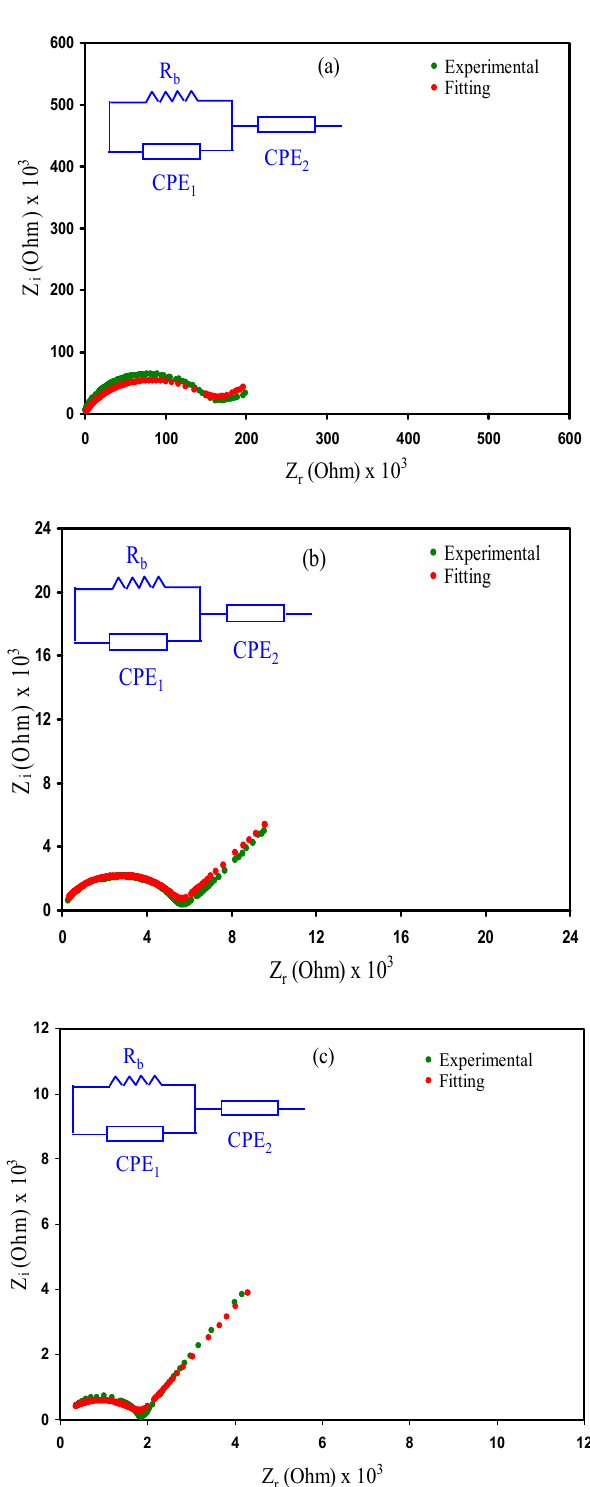
Figure5. Compleximpedanceplot( Z i versus Z r )forthe( a )CSPVMG1, ( b )CSPVMG2, and( c )CSPVMG3 Figure 5. Complex impedance plot ( Z i versus Z r ) for the ( a ) CSPVMG1, ( b ) CSPVMG2, and ( c ) films at room CSPVMG3 films at room temperature.